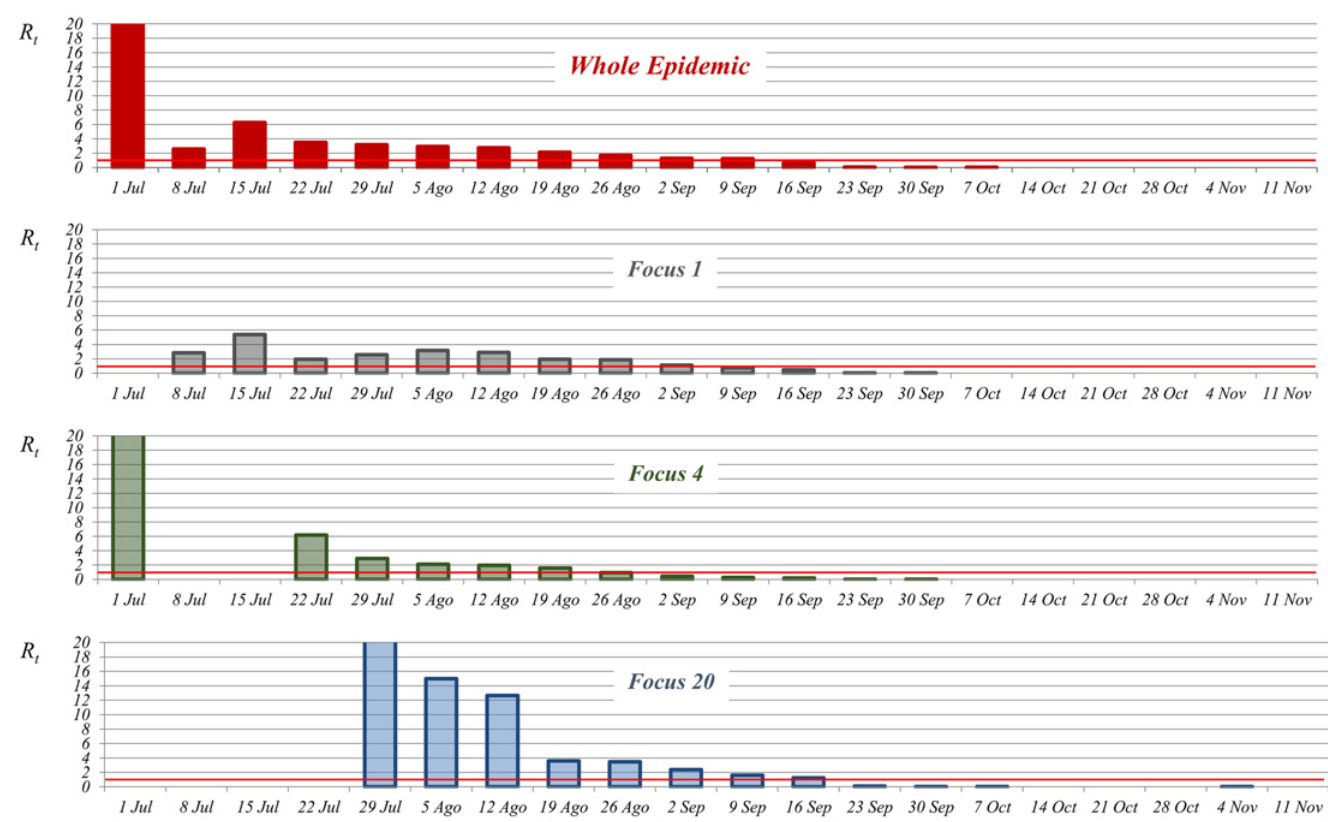
Fig 1. Temporal pattern of the weekly R t values for the whole BTV-1 epidemic in Andalusia and for 3 of the main foci (focus 1, 4, 20) between week 1 (1 st of July) and week 20 (11 th of